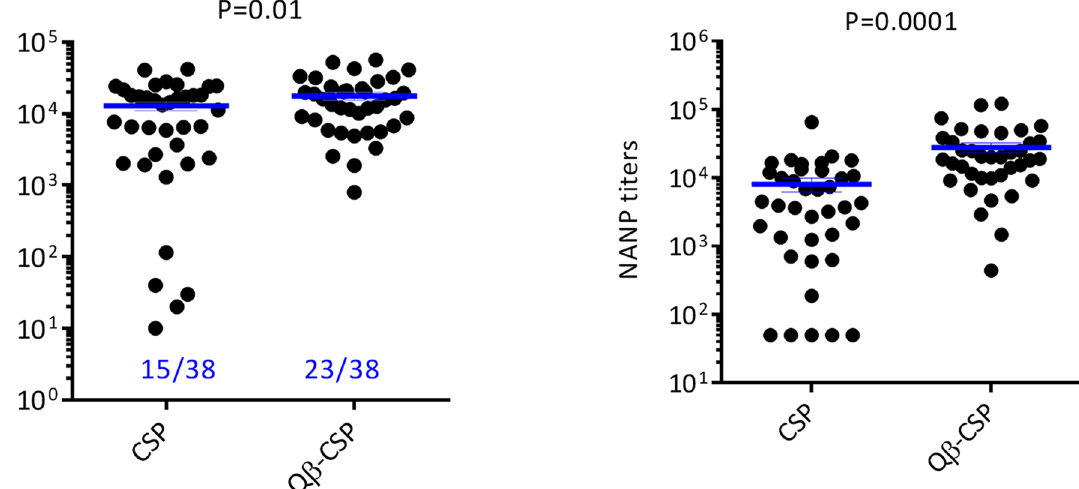
Fig 6. Combined ELISA titer and protection data of CSP vs . Q β -CSP groups. Full-length (left) and NANP (right) titers were plotted for individual animals in Montanide, Alum and SE adjuvanted CSP and Q β -CSP groups. Combined protection data is indicated (blue). Lines are mean ± SEM and the P values are for unpaired T test performed on log transformed